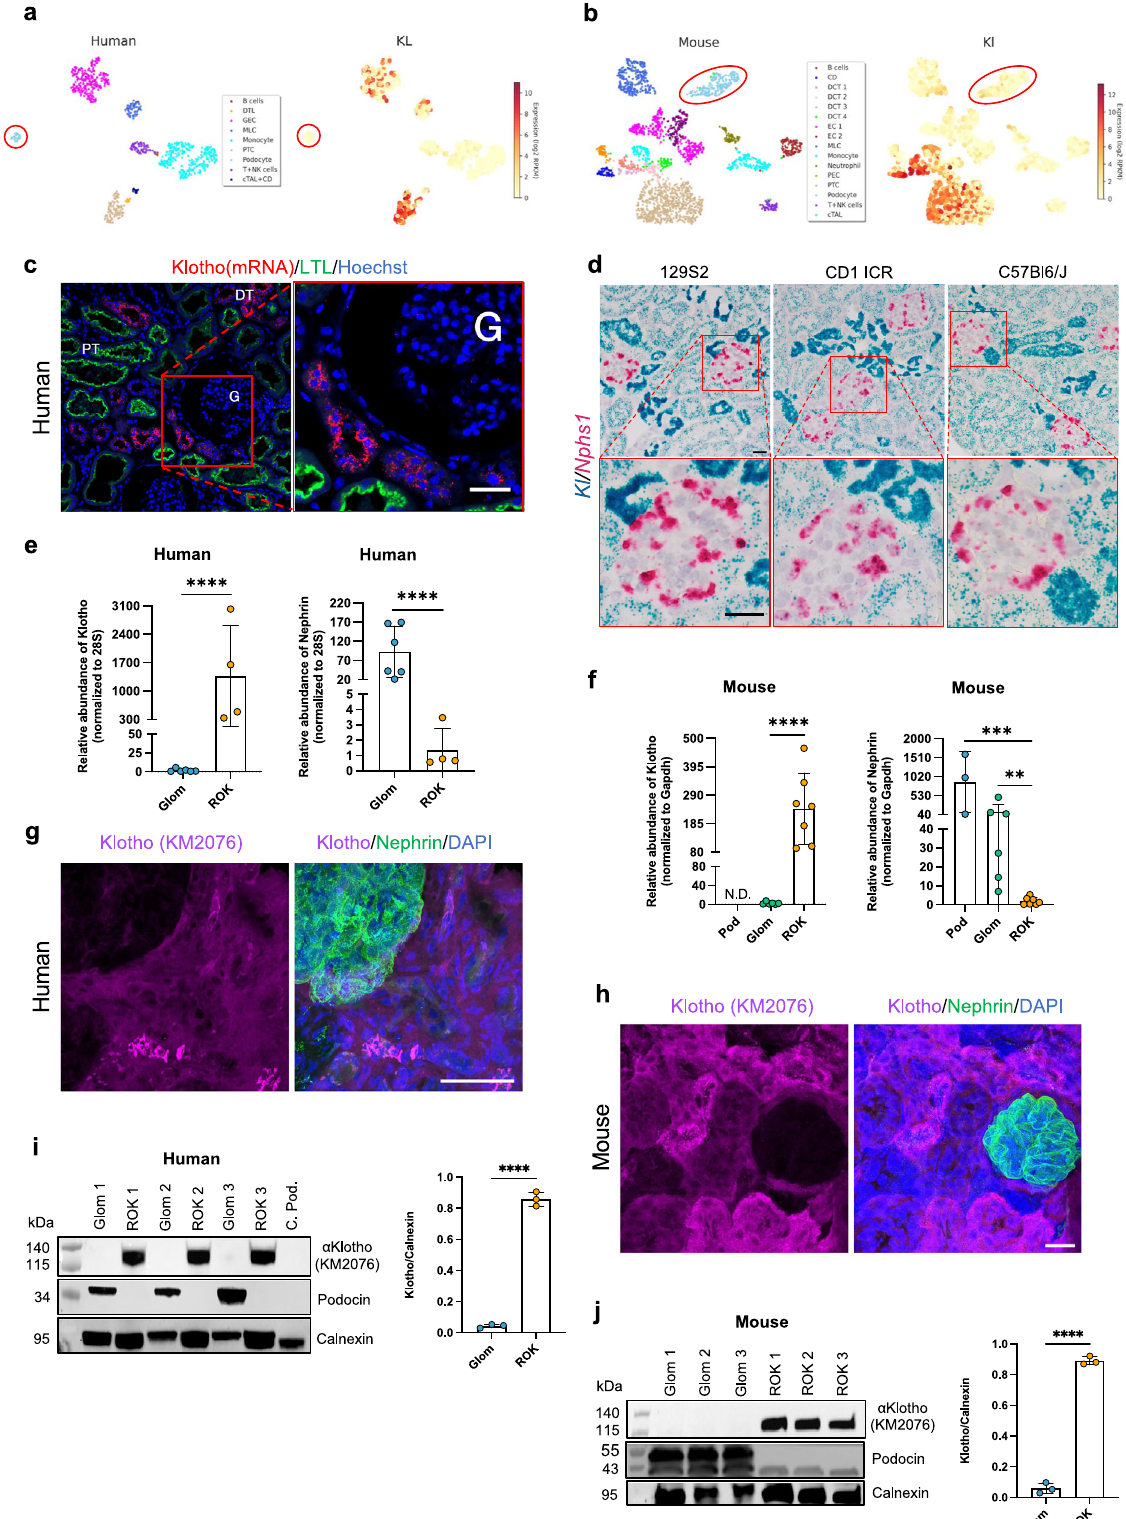
Transgenic mice overexpressing full-length human Klotho in hepatocytes or podocytes display a normal gross phenotype and unchanged mineral metabolism . To understand whether the reported glomeruloprotective effects of Klotho are mediated via local or systemic effects, we generated a transgenic mouse lines in which human full-length Klotho were overexpressed in